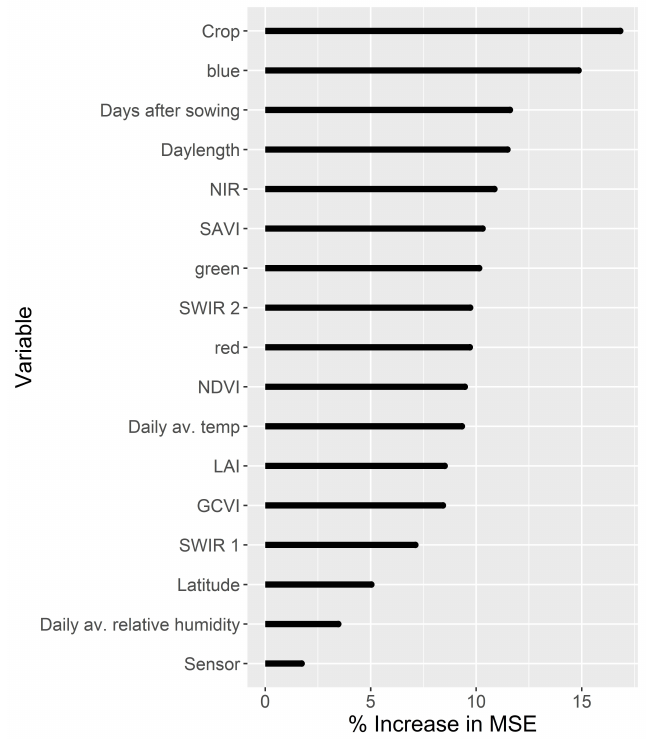
Figure 5. Variable importance plot for the random forest regression model using all predictors shown in Table 3, expressed as percentage increase in mean square